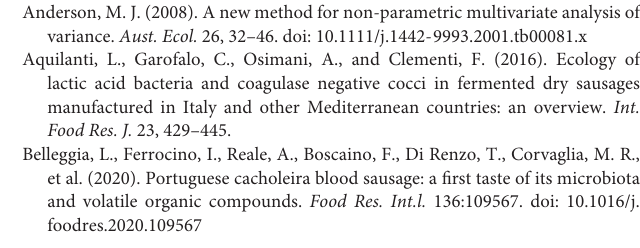
step on the quantity and quality of DNA. Supplementary Table 11 | Selected bacteria calculation of 16S rRNA copy